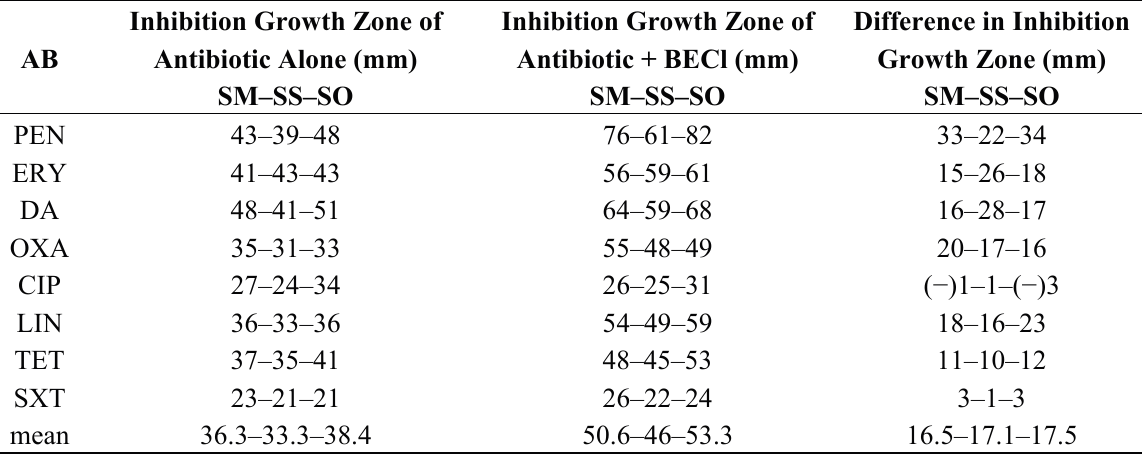
Table 4. The combined antimicrobial effect of antibacterial agents (AB) and berberine (BECl ¼ MIC 90 ) towards the reference oral streptococci strains: S. mutans (SM), S. sanguinins (SS), S. oralis (SO). Alteration of inhibition growth zone of tested antibiotics in combination with berberine (inhibition growth zones in